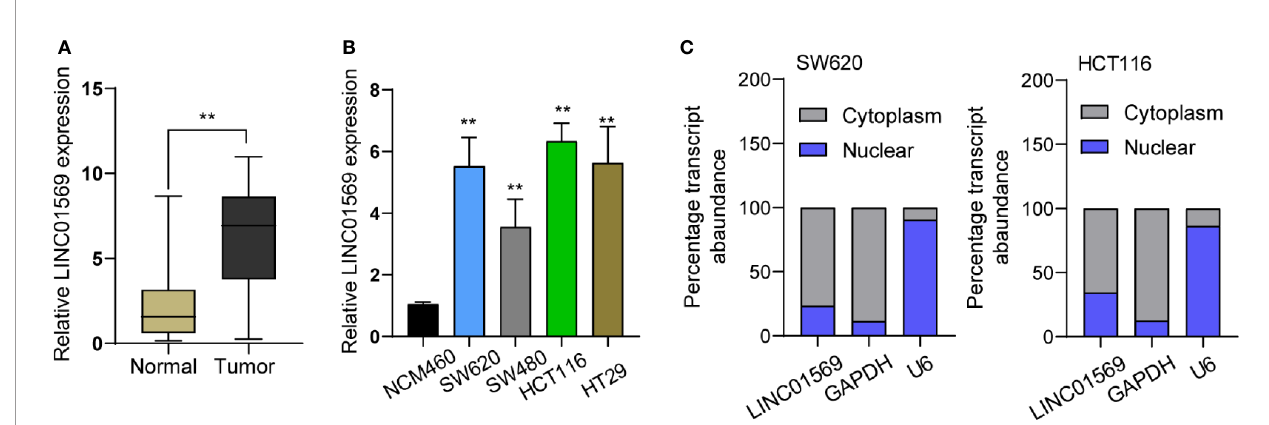
FIGURE 1 | LINC01569 expression was upregulated in CRC and was correlated with prognosis. (A) qRT-PCR assays of the expression of LINC01569 in a 12-pair CRC specimen and corresponding non-tumor samples. (B) The expression of LINC01569 within CRC cell lines (SW620, HCT116, SW480, and HT29) and the epithelial colonic cell line (NCM460) via qRT-PCR analysis. (C) Relative LINC01569 amount within nuclear along with cytosolic fractions of SW620 and HCT116 cells. **P <